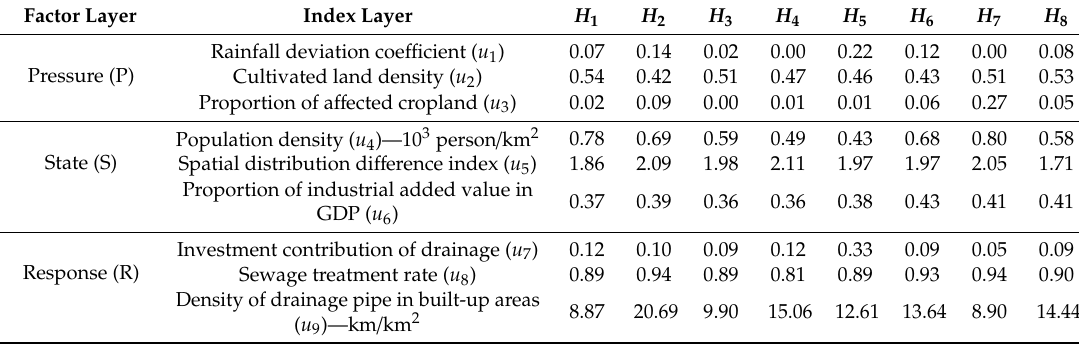
Table 1. Values of